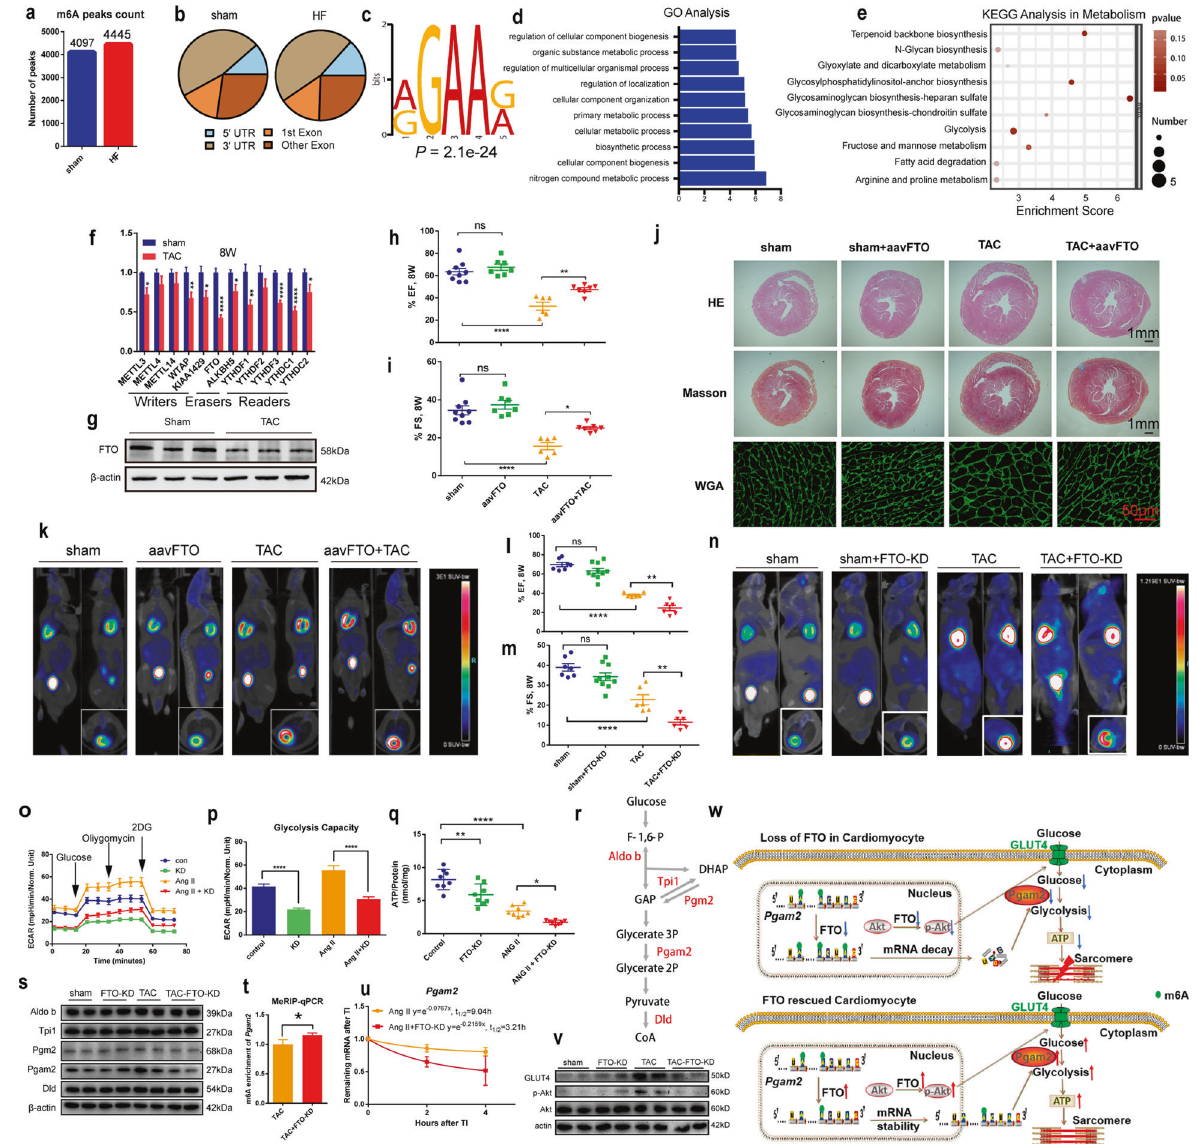
Fig. 1 m6A demethylase FTO attenuates cardiac dysfunction by regulating glucose uptake and glycolysis in mice with pressure overload- induced heart failure. a Total m6A peaks identi fi ed by MeRIP-seq in sham and TAC mice. b Distribution of m6A peaks throughout mRNA lengths. c Sequence logo representing the consensus motif identi fi ed by Discriminative Regular Expression Motif Elicitation (DREME). d Top 10 enriched GO terms from MeRIP-seq data. e KEGG analysis of altered m6A methylation in metabolic mRNAs. f Quanti fi cation of m6A methyltransferase, demethylase, and methyl-speci fi c binding protein mRNA levels in left ventricles of mice at 8 weeks (W) post-TAC ( n = 6/ group). g Immunoblot of FTO protein levels at 8 weeks post-TAC ( n = 6/group). h , i Echocardiographic ejection fraction (EF) and fractional shortening (FS) measurements indicating left ventricle function at 8 weeks post-TAC ( n = 6 – 9/group). j Representative images of hematoxylin and eosin (HE), Masson ’ s trichrome, and wheat germ agglutinin (WGA) staining. k Representative cardiac 18 F-FDG uptake imaging by micro- PET/CT in FTO-overexpressed mice. l , m EF and FS at 8 weeks post-TAC after FTO knockdown ( n = 6 – 10/group). n Representative cardiac 18 F- FDG uptake imaging in mice with FTO knockdown. o Extracellular acidi fi cation rates (ECARs) of isolated cardiomyocytes using the Seahorse XF Analyzer. p Glycolytic function ( n = 19 – 24/group). q ATP production ( n = 8/group). r Glycolysis diagram with genes affected by m6A methylation (red). s Representative immunoblots of ALDOB, TPI1, PGM2, PGAM2, and DLD ( n = 4/group). t Quanti fi cation of m6A enrichment of Pgam2 mRNA detected by MeRIP-qPCR ( n = 3/group). u Lifetime of Pgam2 mRNA in primary cardiomyocytes by monitoring transcript abundance after transcription inhibition (TI) at different time points ( n = 3/group). v Representative immunoblots of GLUT4 and p-AKT ( n =